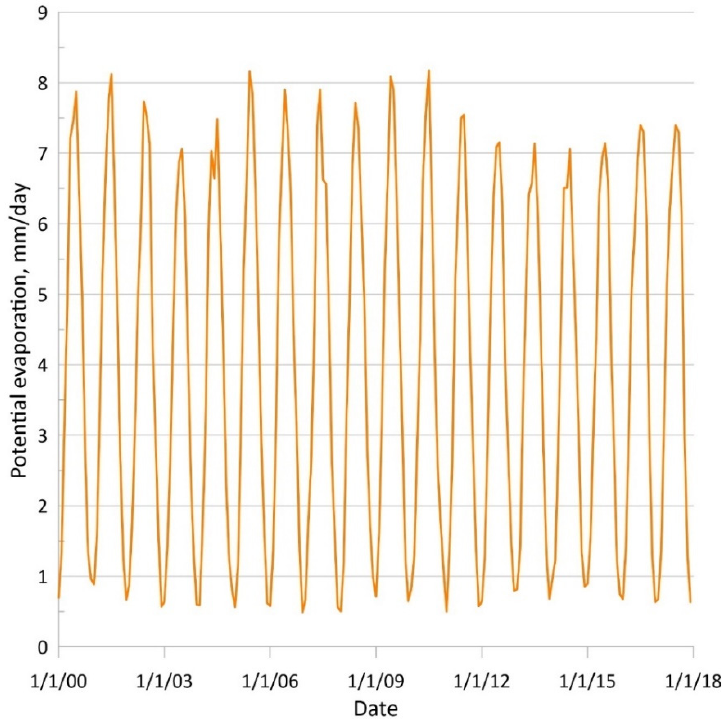
Figure 8. Time series of potential evaporation in the Ejina Basin for the period 2000–2017 calculated using the Penman–Monteith method.